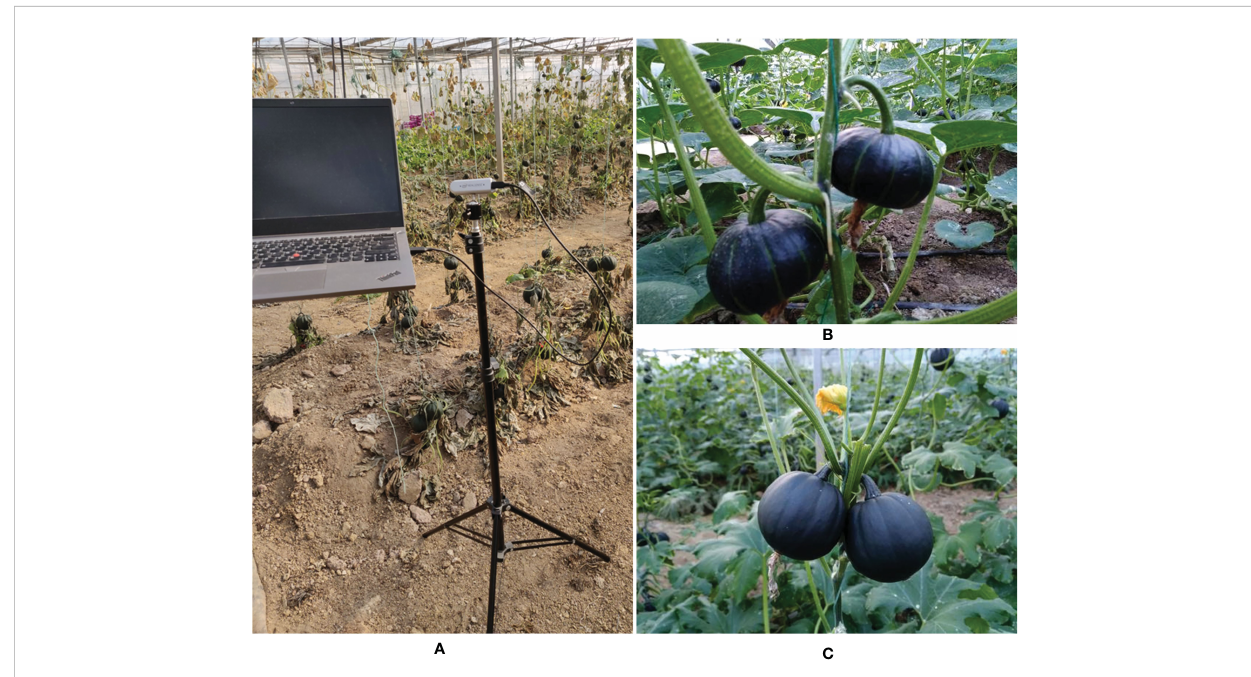
FIGURE 2 Image collection environment and pumpkin images. (A) Image capture scene. (B) Original Bebe pumpkin image. (C) Original Hazel pumpkin